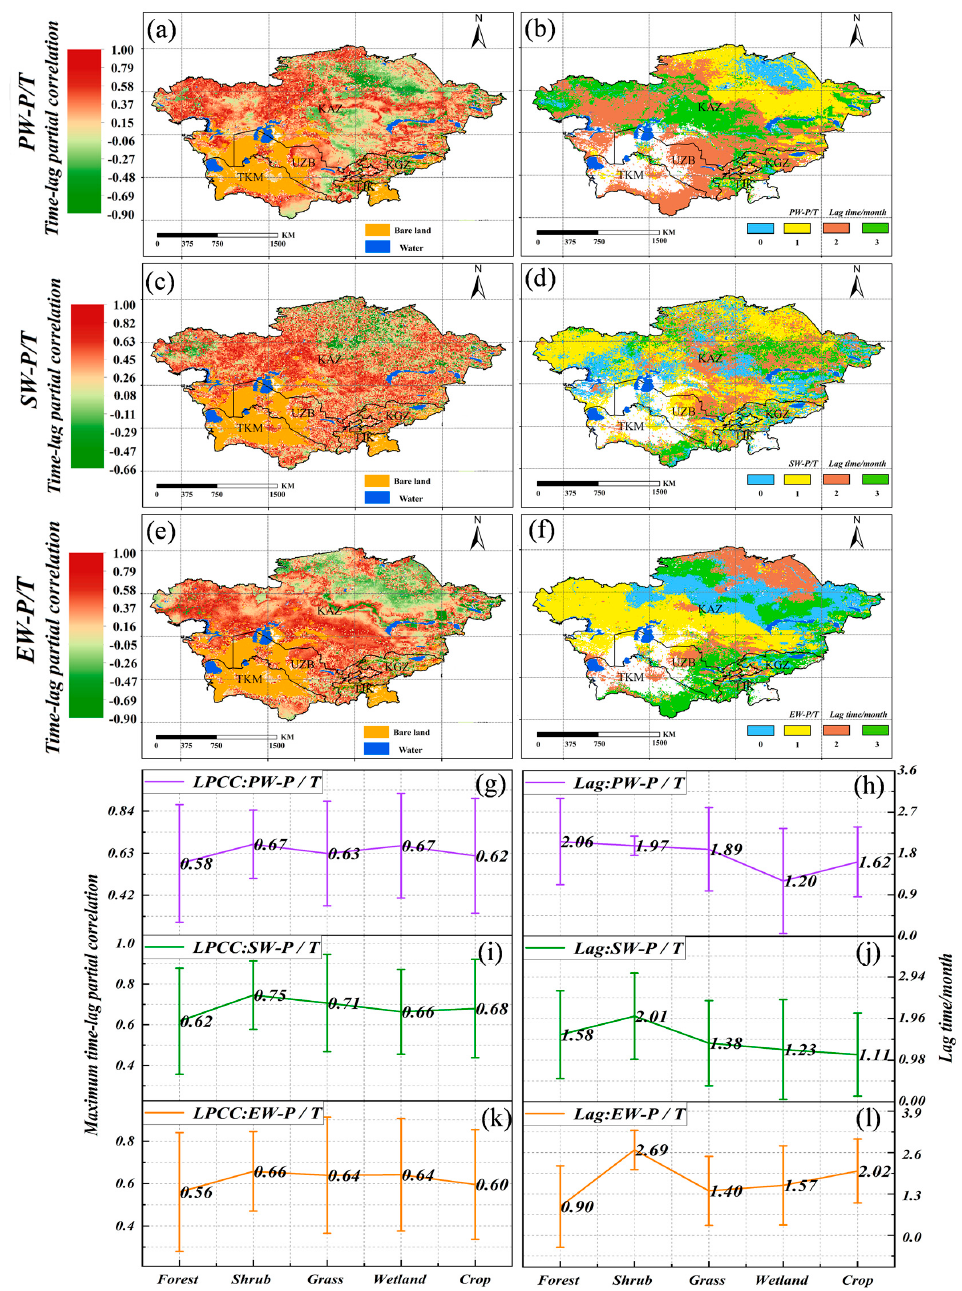
Figure 5. Maximum time-delay partial correlation coefficient: ( a ) PWUE, ( c ) SWUE, ( e ) EWUE and lag time, ( b ) PWUE, ( d ) SWUE, ( f ) EWUE between WUE and precipitation in Central Asia from 2000 to 2018. Partial correlation coefficient: ( g ) PWUE, ( i ) SWUE, ( k ) EWUE and lag time, ( h ) PWUE, ( j ) SWUE, ( l ) EWUE between WUE of different vegetation types and maximum time delay of precipitation. (LPCC: Maximum time-delay partial correlation coefficient.). During the study period, the maximum time lag partial correlation coefficients be- tween LPCC (EW-T/P, SW-T/P, and PW-T/P) and air temperature in Central Asia were all between − 0.99 and 1.00, and the minimum were − 0.74, − 0.99, and − 0.89. A spatial pattern of high in the middle and low in the north and south is evident. Of these measures, the highest LPCC (EW-T/P) in Kazakhstan was 0.7863. Kazakhstan is located in the north-